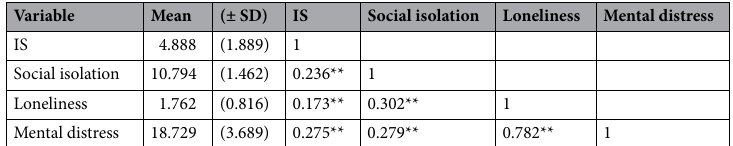
Variable Mean (± SD)